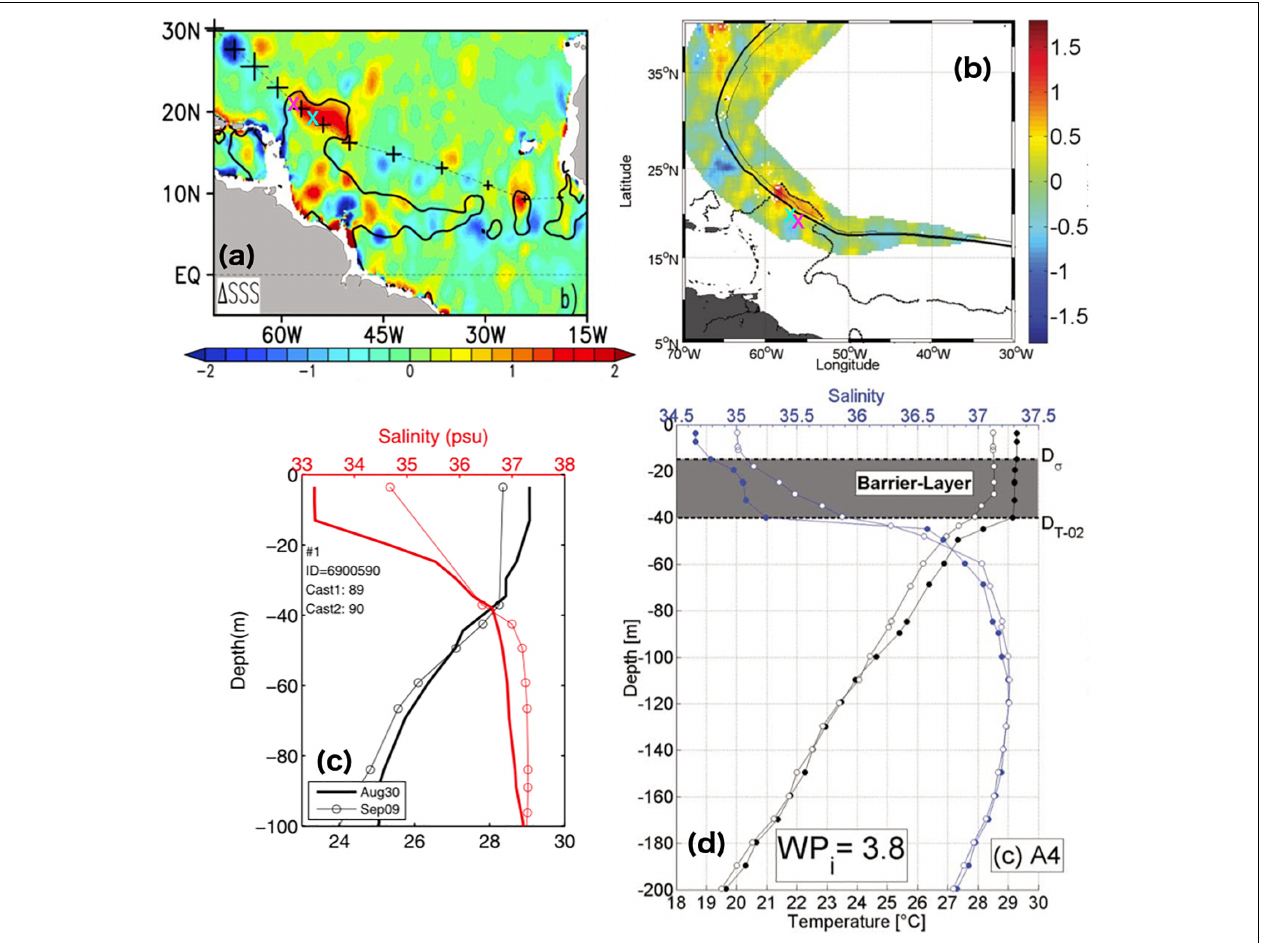
FIGURE 9 | Monitoring hurricanes using satellite SSS data from panel (a) Aquarius and (b) SMOS, respectively, showing differences from after versus before Katia and Igor hurricane passages in the Atlantic Ocean. (c,d) Argo salinity profiles before and after the hurricanes passage. The location of the Argo floats are marked by magenta and cyan crosses in panels (a,b) . Figure sources: Grodsky et al. (2012) and Reul et al. (2014b). Reproduced under license agreement 4445231502401 and